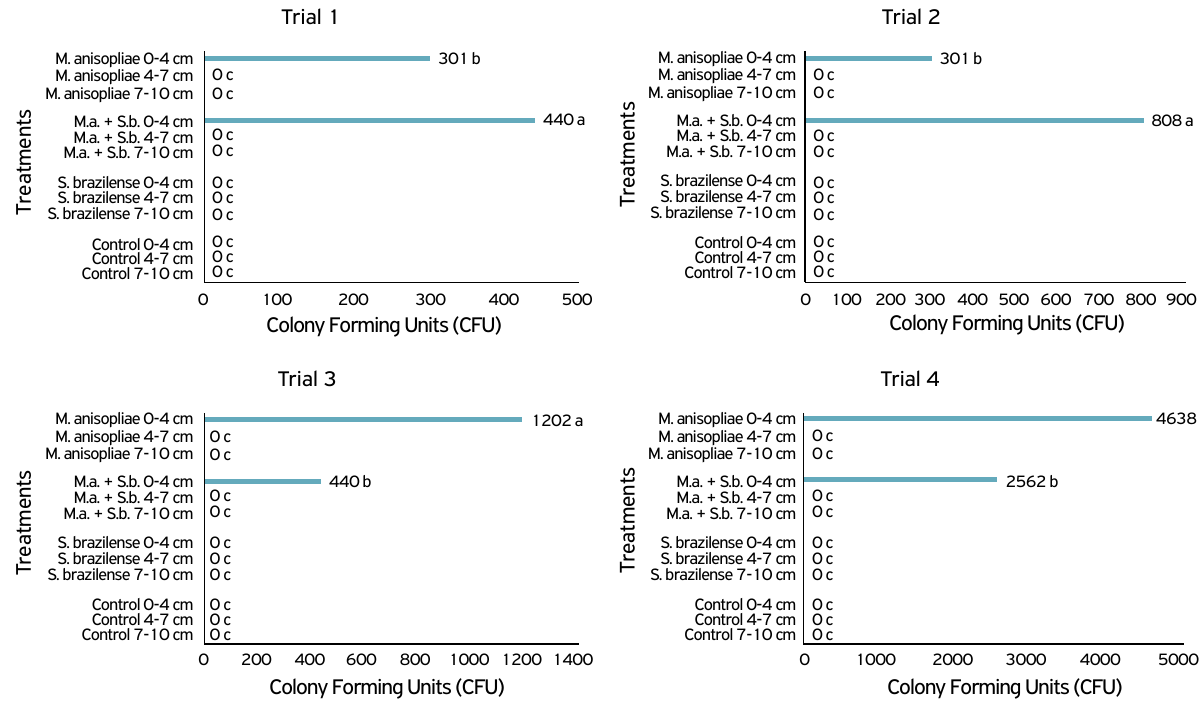
Figure 2. Conidia carriage trials in different depths of sandy soil after application of Metarhizium anisopliae, Steinernema brazilense , the combination of M. anisopliae with S. brazilense (M.a. + S.b.), and control (water) in four repeated trials. Means followed by the same letter do not differ from each other by the Duncan test at 5%